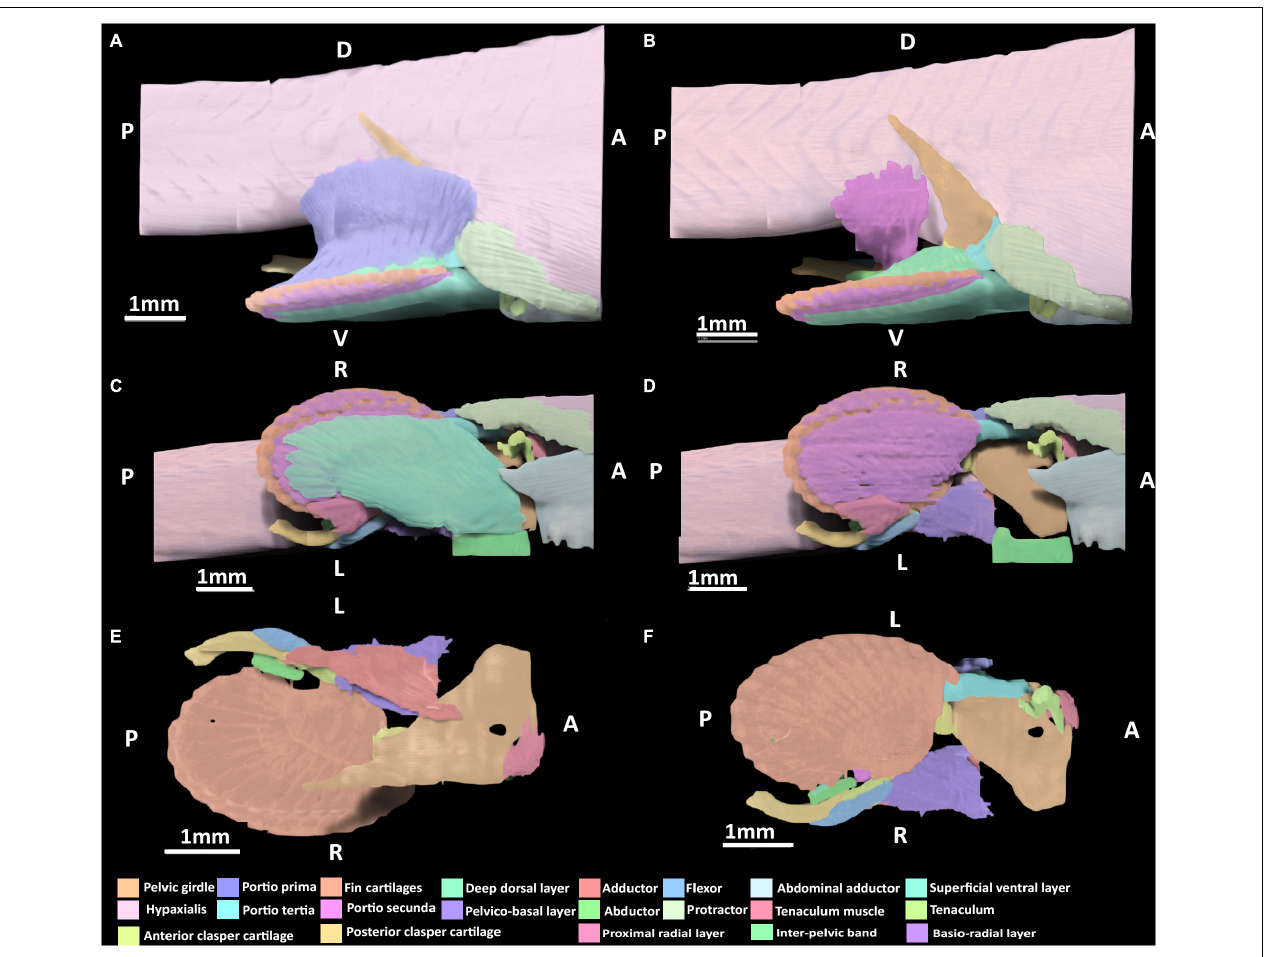
FIGURE 6 | 3D model of the right pelvic musculature of a stage 34 male elephant shark ( Callorhinchus milii ) embryo. (A) Lateral view of musculature, (B) same view but with the portio prima removed, (C) ventral view of musculature, (D) ventral view with the superficial ventral layer removed, (E) dorsal view of the reproductive musculature, (F) ventral view of the reproductive musculature. Anatomical planes and position indicated by lettering: A, Anterior; P, Posterior; D, Dorsal; R, Right; L,